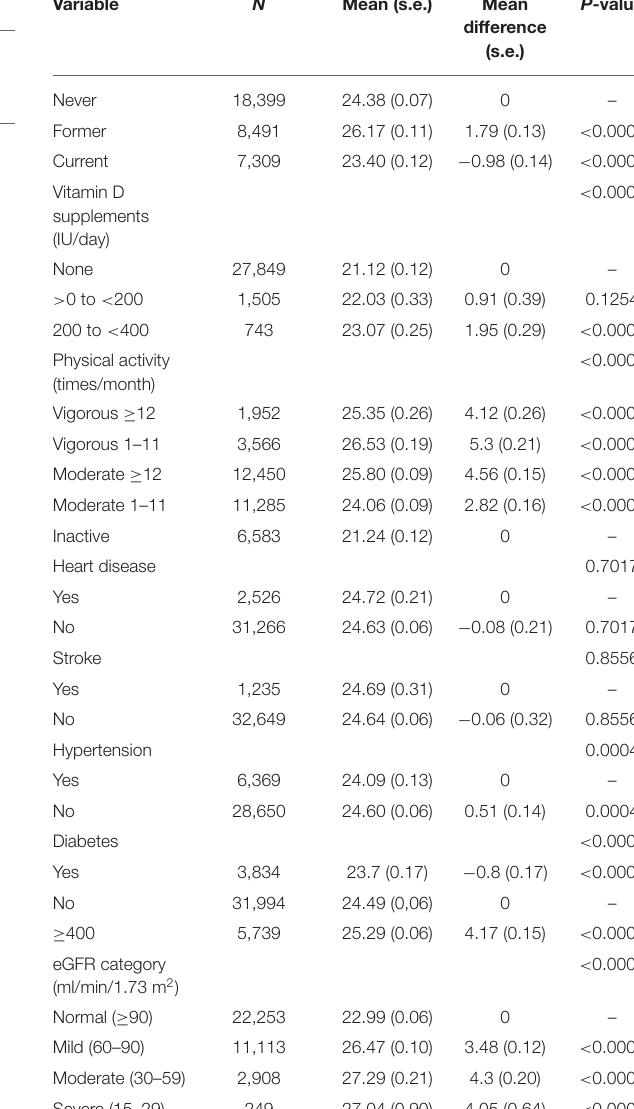
TABLE 1 | Mean (s.e.) and mean difference (s.e.) in serum 25-hydroxyvitamin D (ng/ml) by level of demographic variables, lifestyle variables influencing vitamin D status, and eGFR